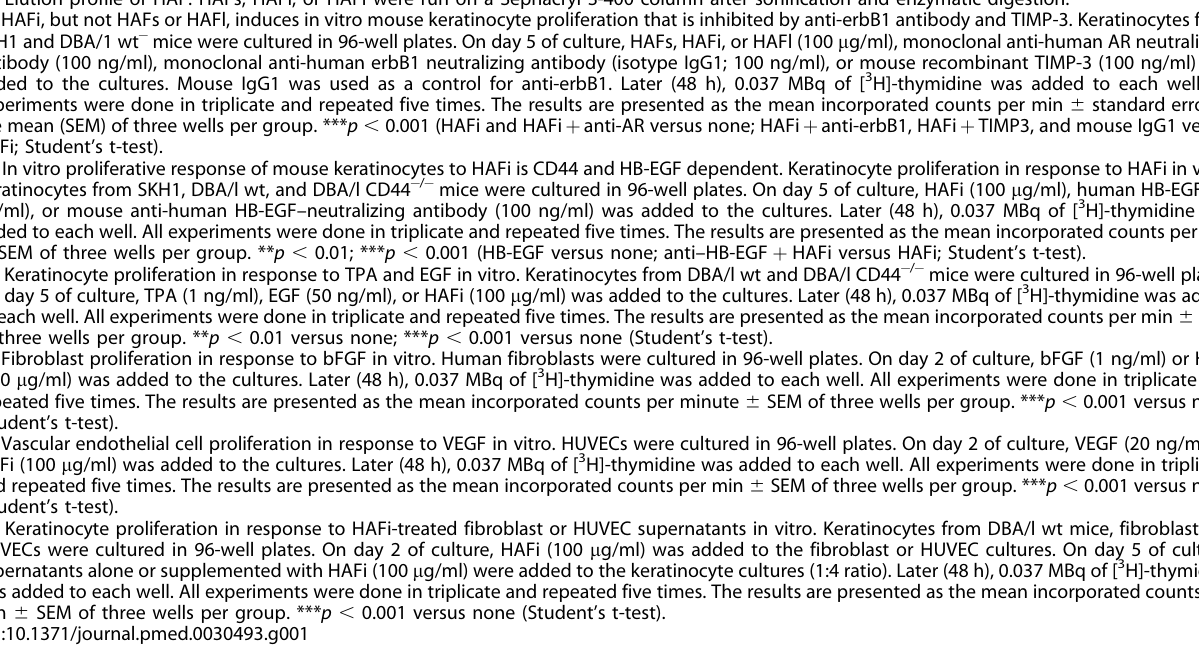
(G) Keratinocyte proliferation in response to HAFi-treated fibroblast or HUVEC supernatants in vitro. Keratinocytes from DBA/l wt mice, fibroblasts, or HUVECs were cultured in 96-well plates. On day 2 of culture, HAFi (100 l g/ml) was added to the fibroblast or HUVEC cultures. On day 5 of